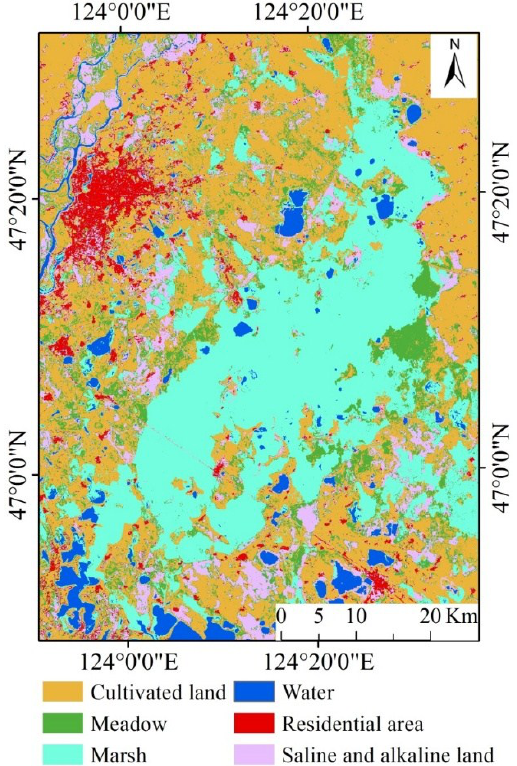
Figure 6. The random forest (RF) classification results based on OLI (operational land imager) + SAR (synthetic aperture radar) + HRF (hydrological regimes features) model.